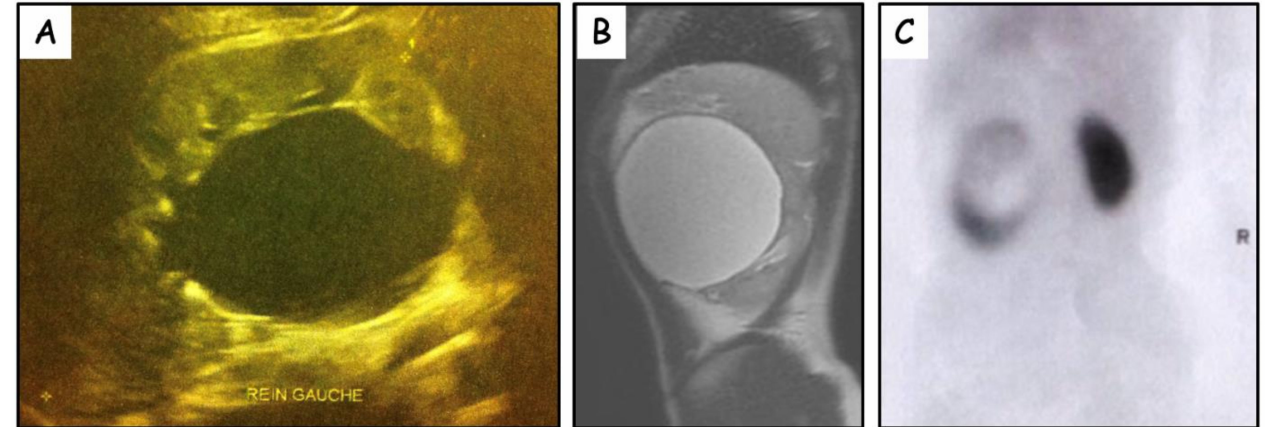
Figure 1. ( A ) Renal ultrasound. Large fluid-filled structure mimicking a grossly dilated renal pelvis (42 mm antero-posterior diameter). No caliceal dilatation. ( B ) Pre-operative MRI (sagittal view) demonstrating very large cystic lesion adjacent to the left renal pelvis. ( C ) Pre-operative DMSA renal scan demonstrating photopenic lesion (cyst) occupying the central zone of the left kidney.